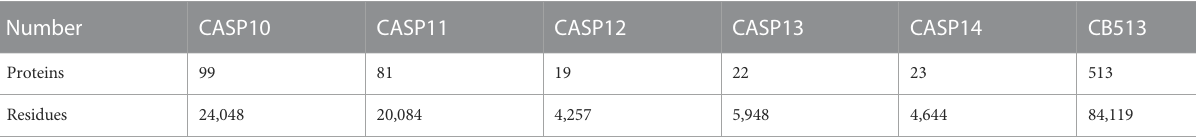
TABLE 1 The number of proteins and residues for the six